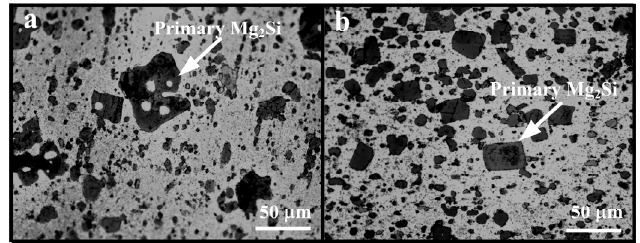
Figure 4. Microstructures of primary Mg 2 Si in hot ‐ extruded (extruding temperature: 460 °C) and T6 treated (solution temperature and time: 500 °C/2h, aging temperature and time: 175 °C/8h) alloys: ( a ) Al–18Mg 2 Si–4.5Cu, ( b ) Al–18Mg 2